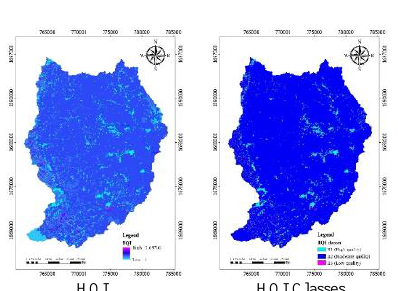
HQI HQI Classes Figure 10. The distribution of human activity index classification